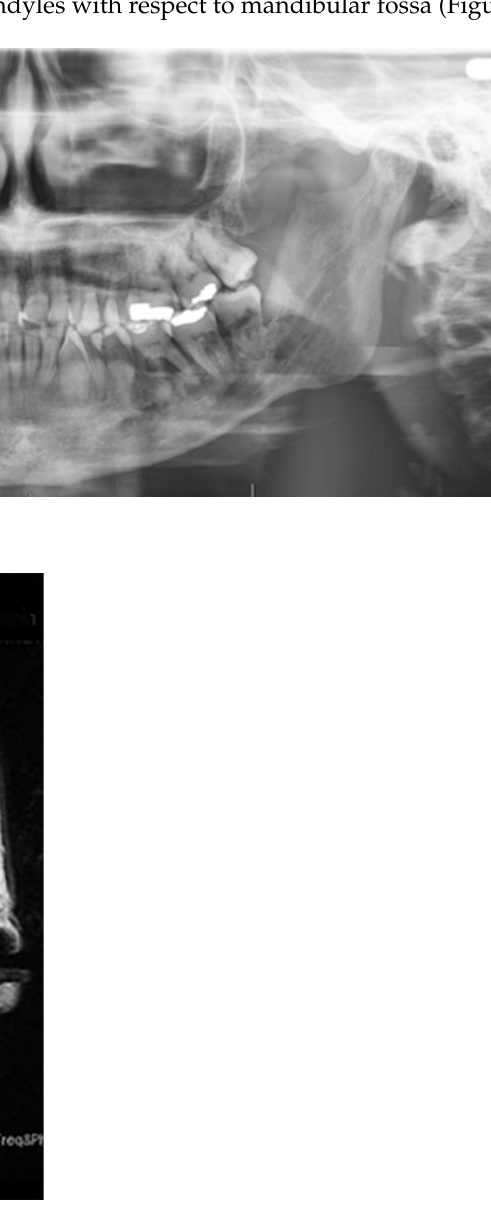
Figure 2. Pre-operative MRI. An intra-oral scar band release, bilateral temporalis flap, split thickness skin graft (STSG), bilateral posterior dental clearance and mandible corticotomy and tracheostomy was performed after completing 34 treatments of hyperbaric oxygen therapy (HBOT) under general anaesthesia. An awake nasal fibreoptic intubation was performed due trismus, 35 mL of 0.5% Marcaine + 1:100,000 adrenaline was administered intra-orally as local anaesthesia. Dental extractions of all posterior molars with alveoloplasty and corticotomy of ORN bone until bleeding was performed. Bilateral mandibular vestibular incisions of 40 mm were made, with blunt dissection exposing the mandibular ramus and posterior bodies. The right coronoid process and bilateral scar tissue from masseter and medial pterygoid was excised, leaving defects approximately 25 × 35 mm in size. Bilateral hemicoronal incisions extending inferiorly to the preauricular region at the level of